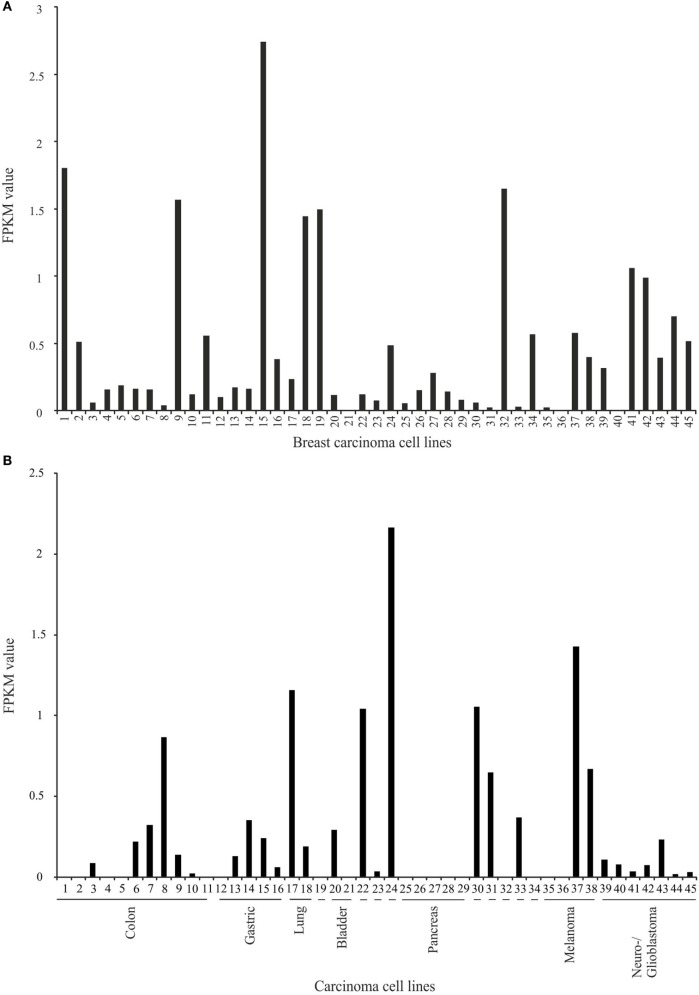
Expression analysis of OR2B6 in breast carcinoma cell lines and carcinoma cell lines that originated from other carcinoma types. (A) Expression of OR2B6 in 45 breast carcinoma cell lines. For further details on cell lines, see Table S1 in Supplementary Material. (B) Expression of OR2B6 in 45 other carcinoma cell lines, except breast carcinoma cell lines. 19: cell line that originated from osteosarcoma; 22: cell line that originated from prostate carcinoma; 23: cell line that originated from leukemia cells; 24: cell line that originated from germ cell carcinoma; 30: cell line that originated from cervix carcinoma; 31: cell line that originated from synovial sarcoma; 32: cell line that originated from Ewing sarcoma; 33: cell line that originated from myosarcoma; 34: cell line that originated from fibrosarcoma. For further details on cell lines, see Table S3 in Supplementary Material.